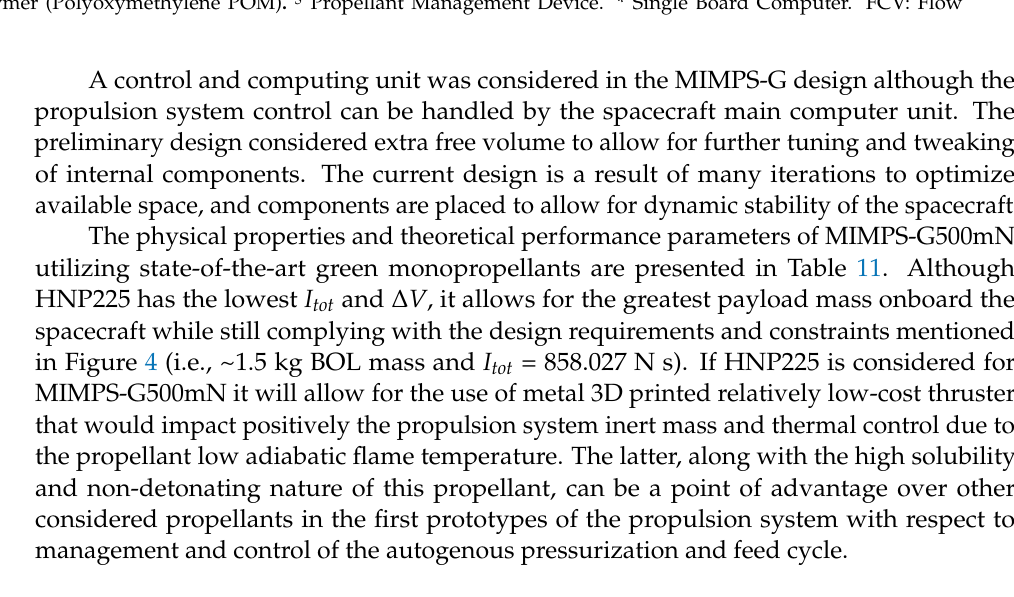
Table 11. Specifications and theoretical performance of MIMPS-G500mN using the selected green